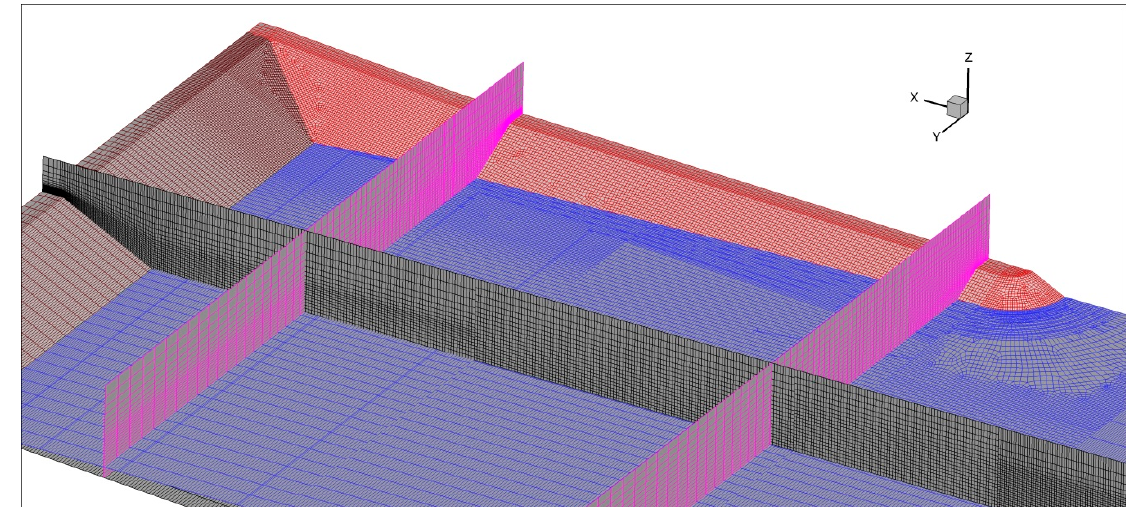
Figure 19. Mesh on groin (red) and dike (brown) face and several planes: free surface at rest (blue), x-planes x = 329, and 395 m (purple) and y-plane y = 59 m (black).